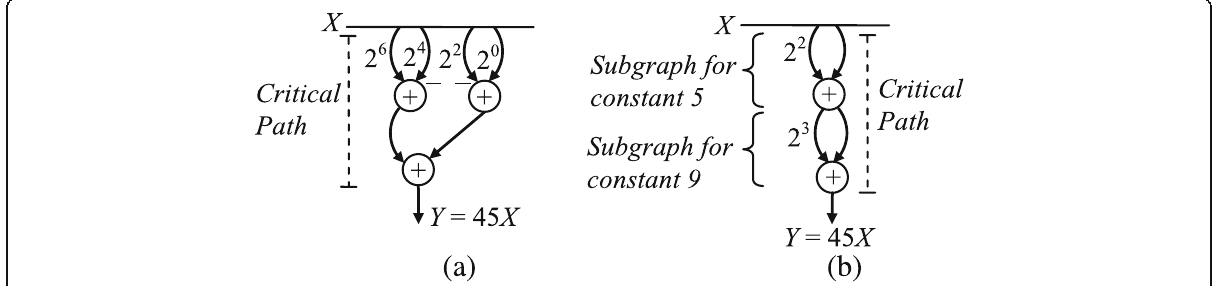
Fig. 4 Structure of the product 45 X a constant 45 expressed in CSD and b constant 45 in graph representation using two input adders